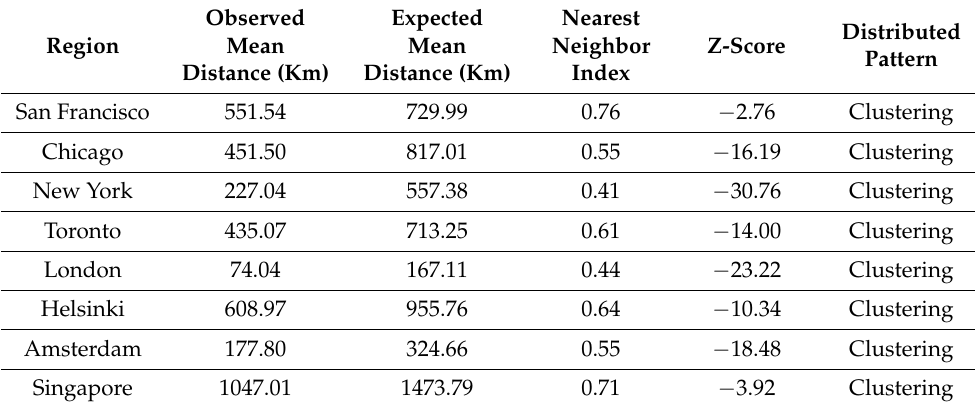
Table 1. Parameters of the average nearest neighbor analysis of green